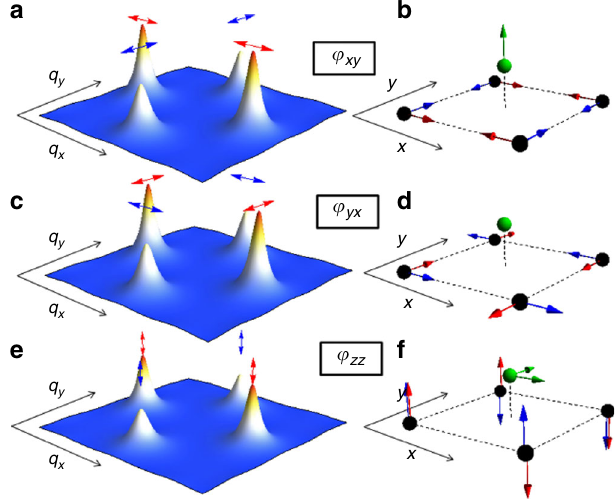
Fig. 3 Spin-space structure of the spin-nematic order parameter. Spin fl uctuations in momentum space (left) and in real space (right) and polarization directions of the Fe spins for the three nematic components, φ xy ( a , b ), φ yx ( c , d ), and φ zz ( e , f ). The red arrows correspond to the magnetic ordering vector Q 1 = ( π , 0) and the blue arrows correspond to Q 2 = (0, π ). The black spheres are the Fe sites, the green sphere is the As site, and the green arrows indicate the direction of the hyper fi ne fi